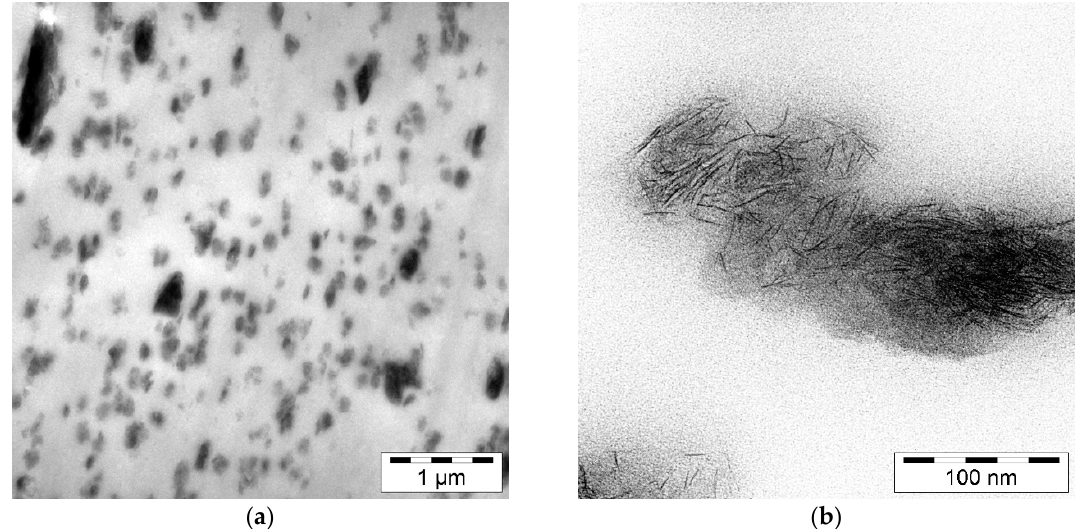
Figure 1. Transmission Electron Microscopy (TEM) images of the 6% laponite in LDPE film: ( a ) low and ( b ) high resolved image.